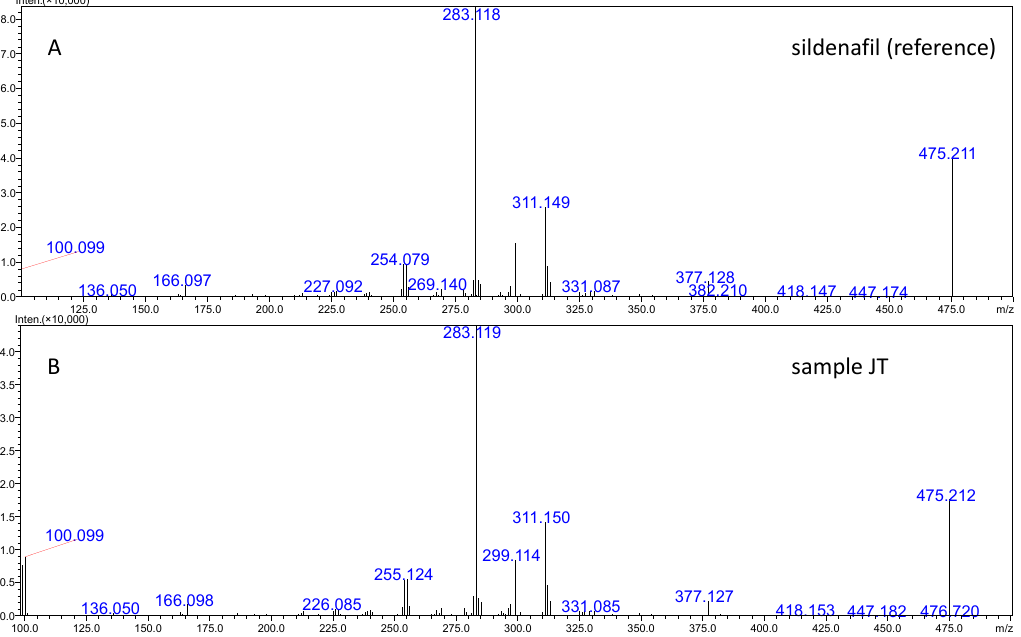
Figure 2. Comparison of the MS/MS spectra of ( A ) sildenafil standard and ( B ) dietary supplement sample JT. Precursor ion m / z = 475.210, CE = 40 ± 10 eV.